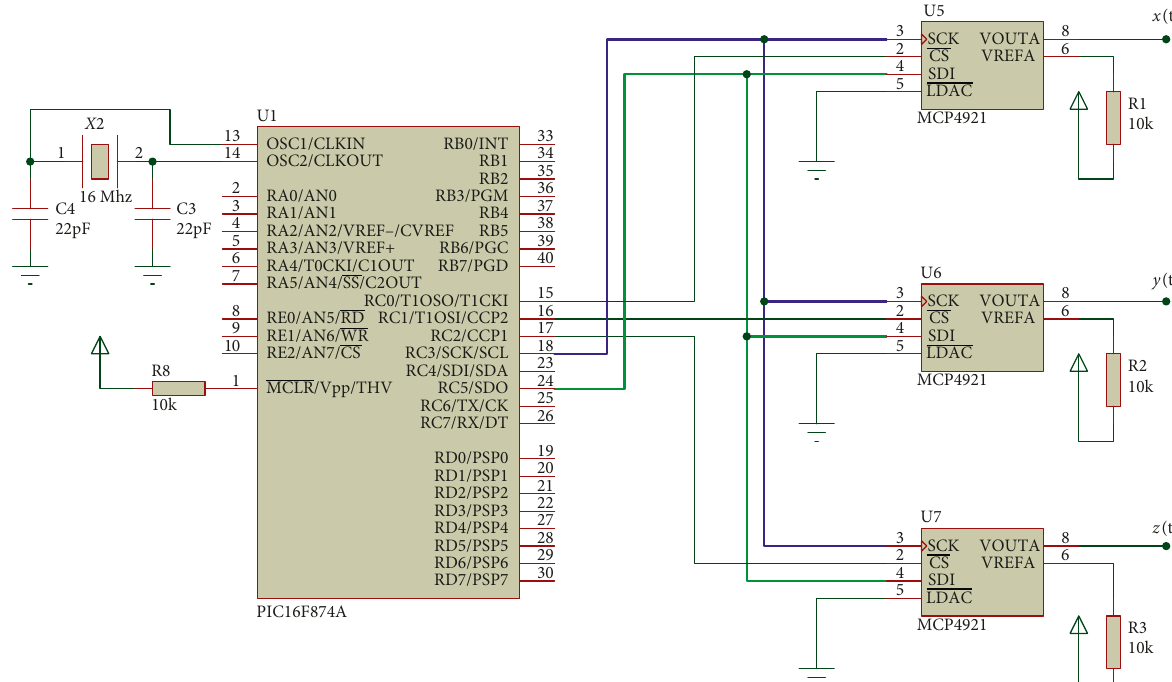
Figure 6: Schematic of the simulation of ES in V1 with the Proteus